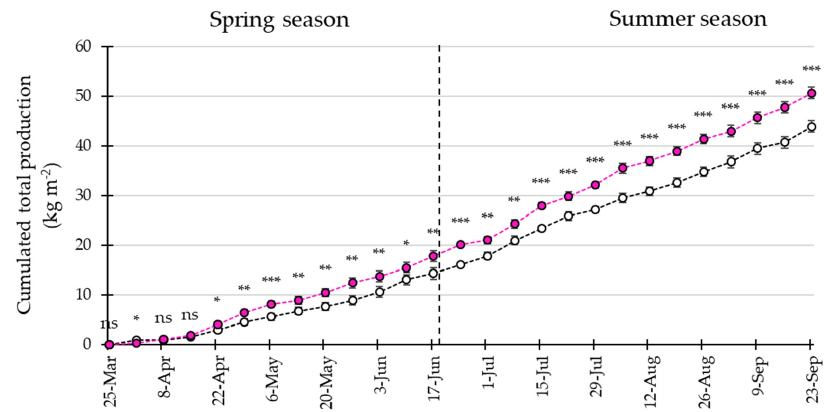
Figure 7. Effect of supplemental LED interlighting (pink) and control treatment (white) on the cumulated total production for spring and summer season. Symbols (*) indicate significant differences at p ≤ 0.05 (*), 0.01 (**), or 0.001 (***), “ns” indicates non ‐ significant differences at p ≤ 0.05.